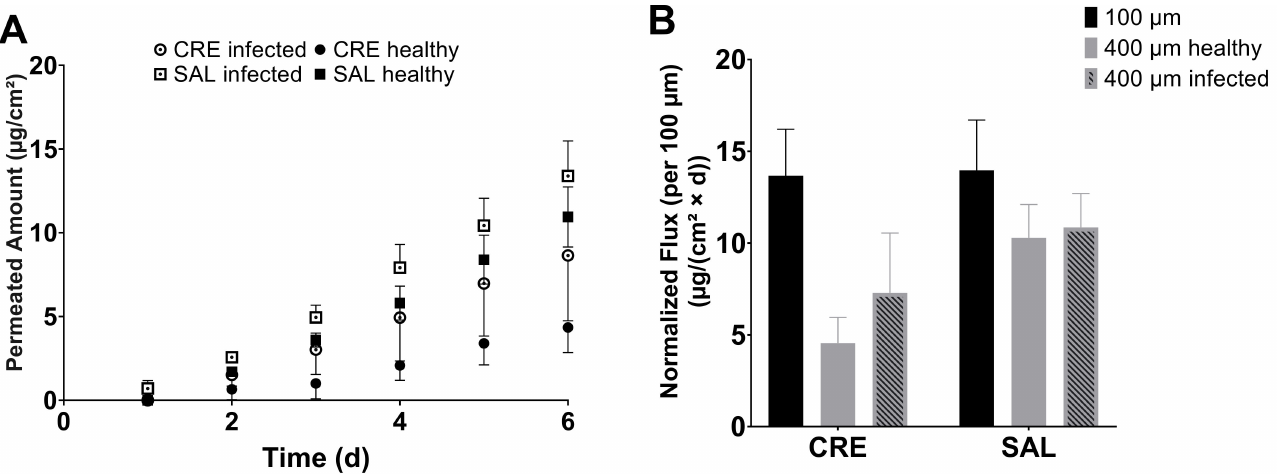
Figure 7. ( A ) Permeation of bifonazole from Canesten ® Extra Creme (CRE) and Canesten ® Extra Salbe (SAL) across 400- µ m bovine hoof sheets and healthy and infected with T. rubrum (mean ± SD). ( B ) Respective fluxes of bifonazole through 100- µ m and 400- µ m healthy and infected membranes (mean ±